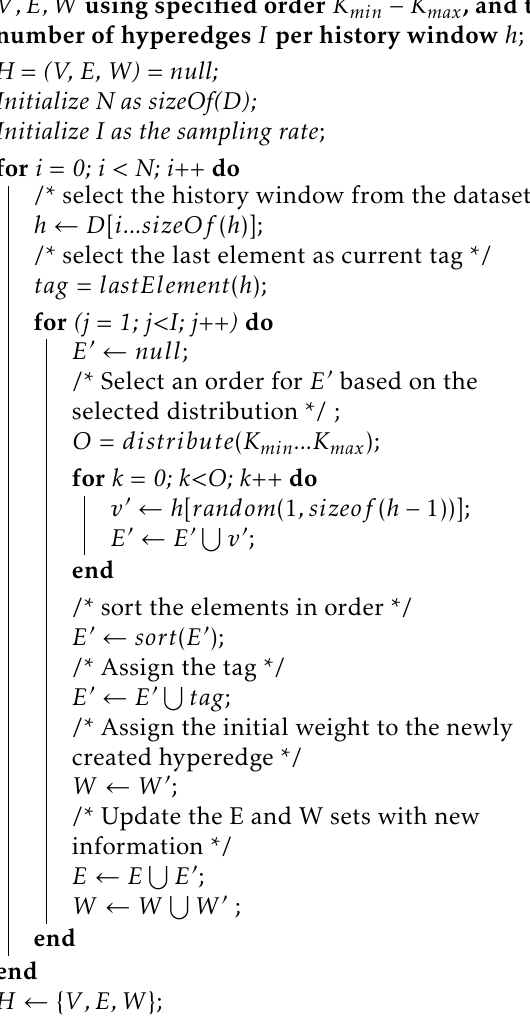
Algorithm 1: Hypernetwork creation